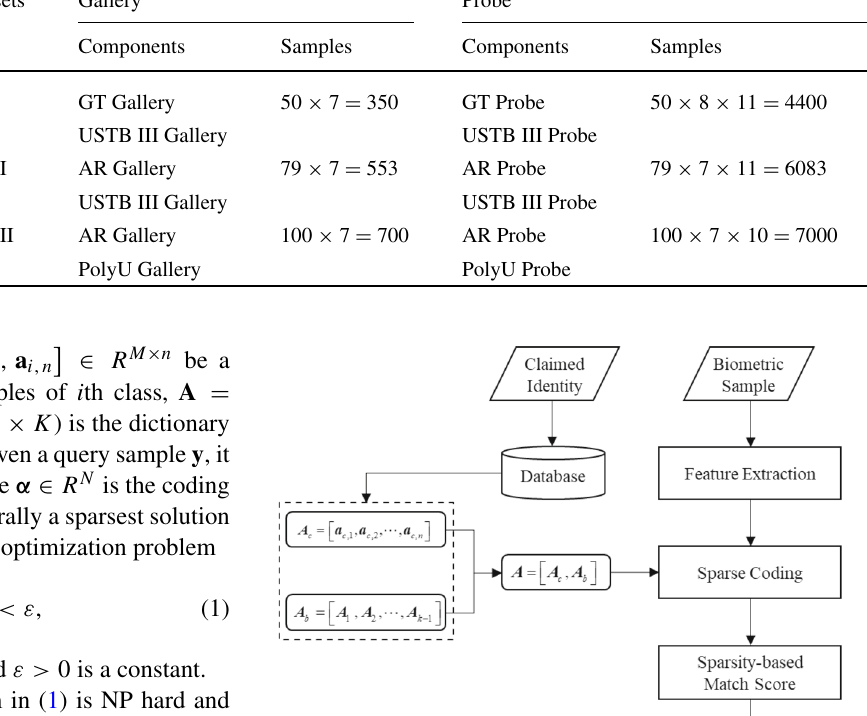
Table 2 The constitution of the chimeric multimodal datasets Datasets Gallery Probe